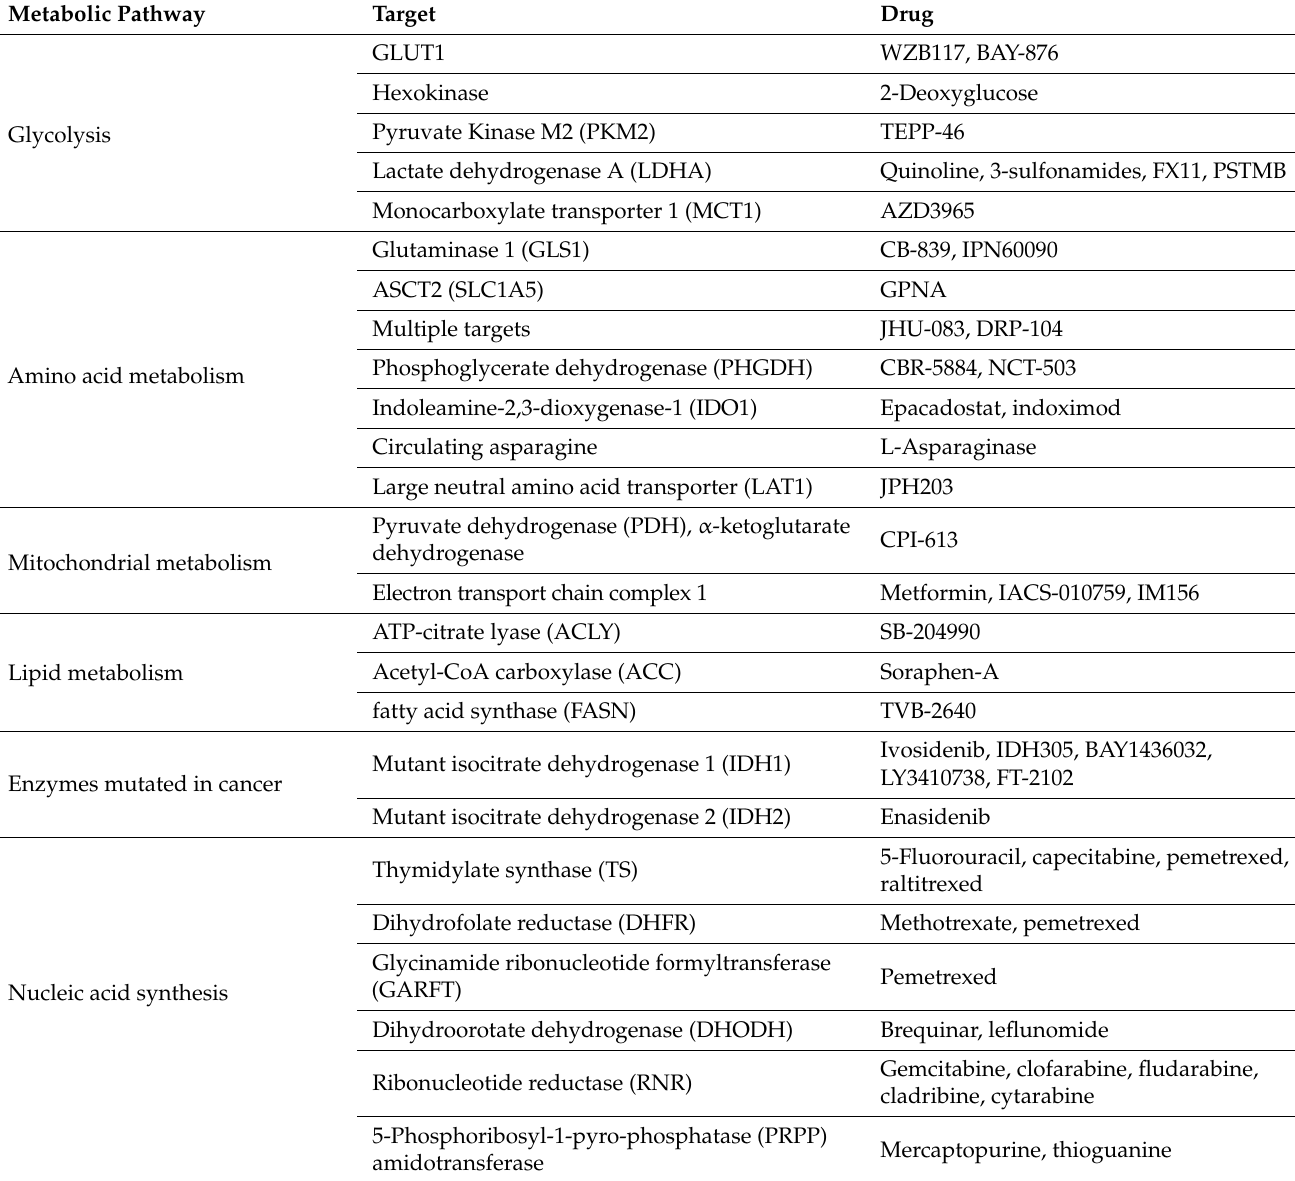
Table 1. Cancer drugs targeting metabolic pathways that are approved, or under investigation in clinical